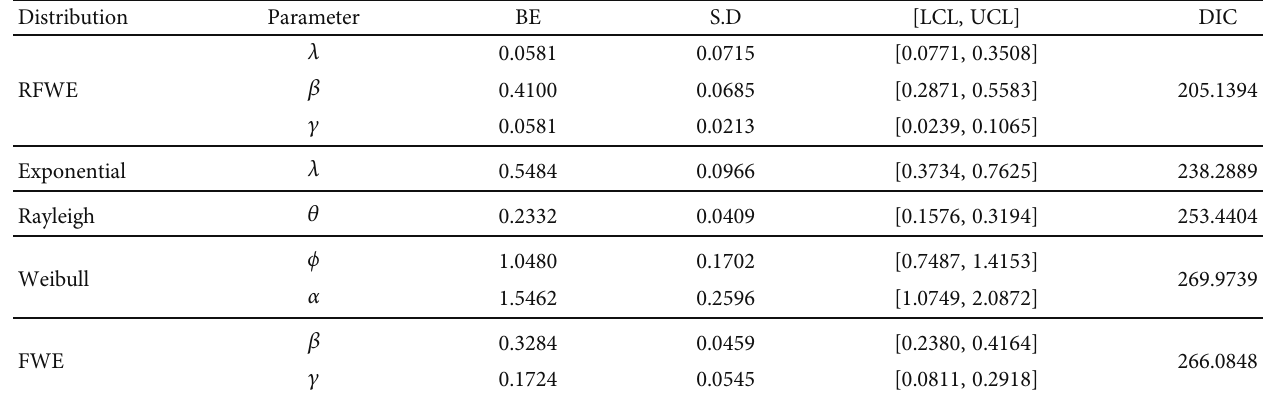
Table 6: Posterior results under gamma prior distribution.